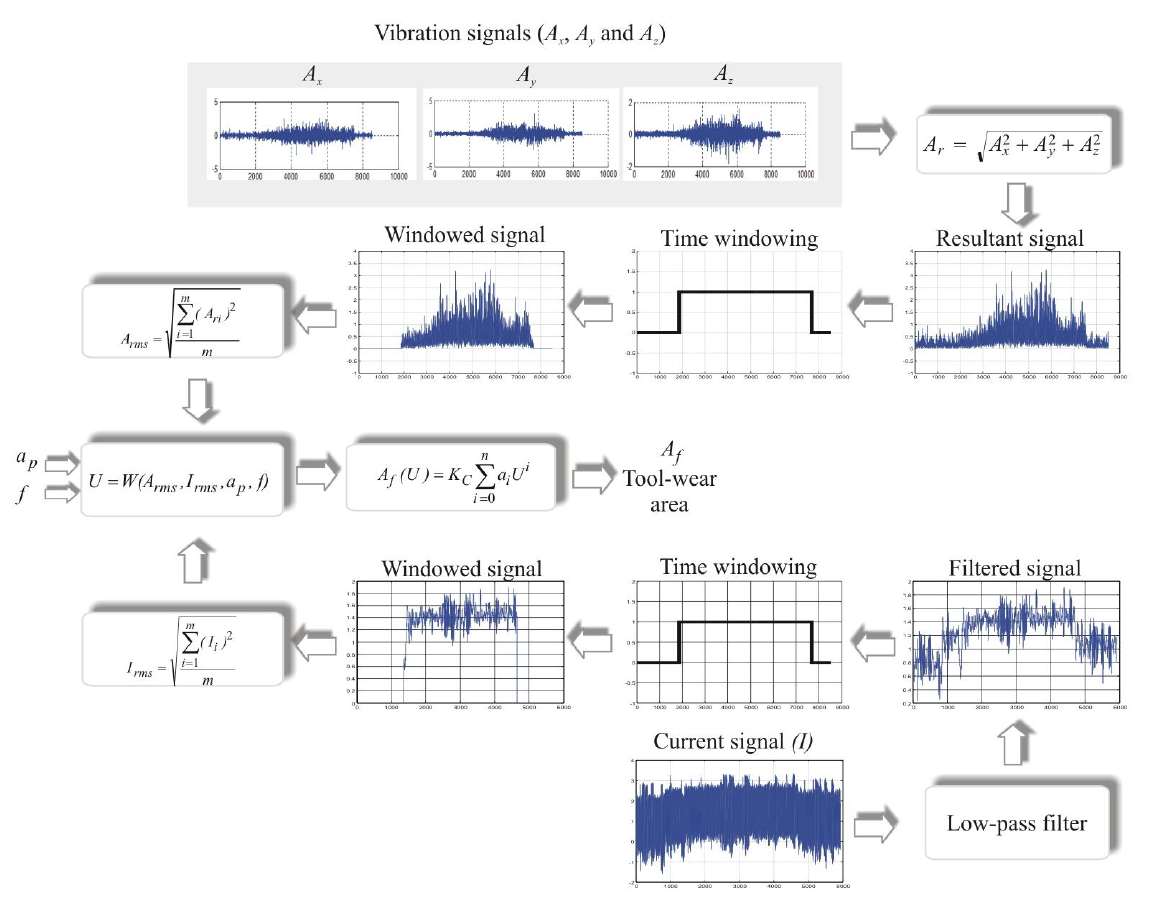
Figure 4. Vibration and current signal